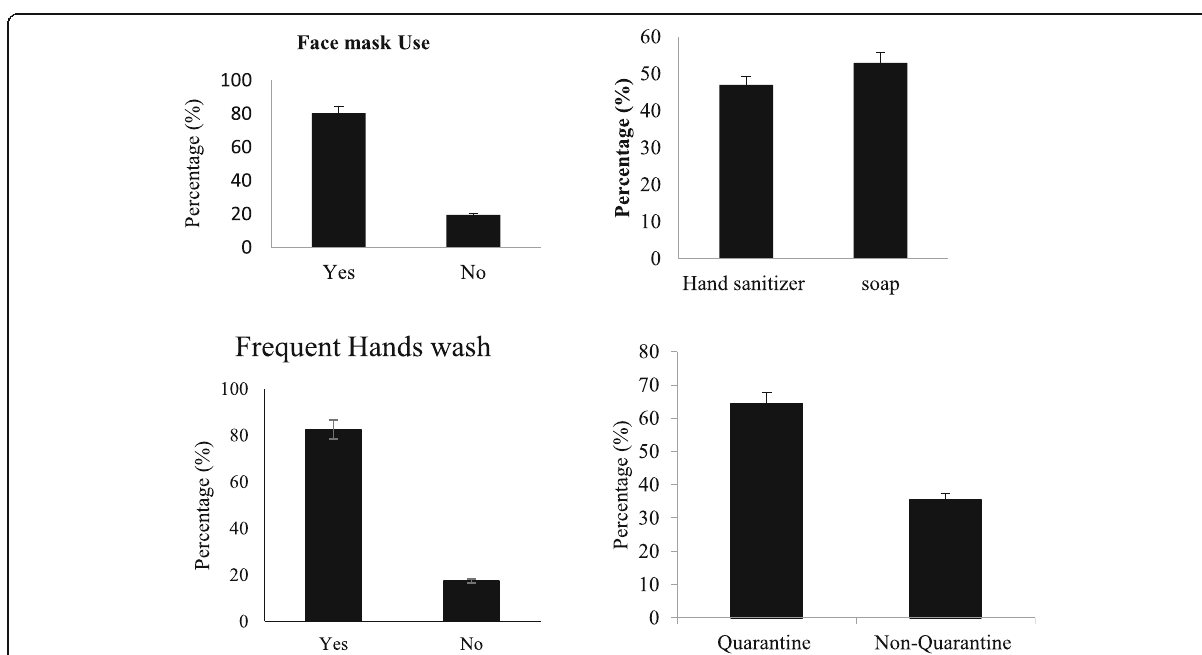
Fig. 4 Percentage proactive measures taken by HCV-infected respondents against COVID-19